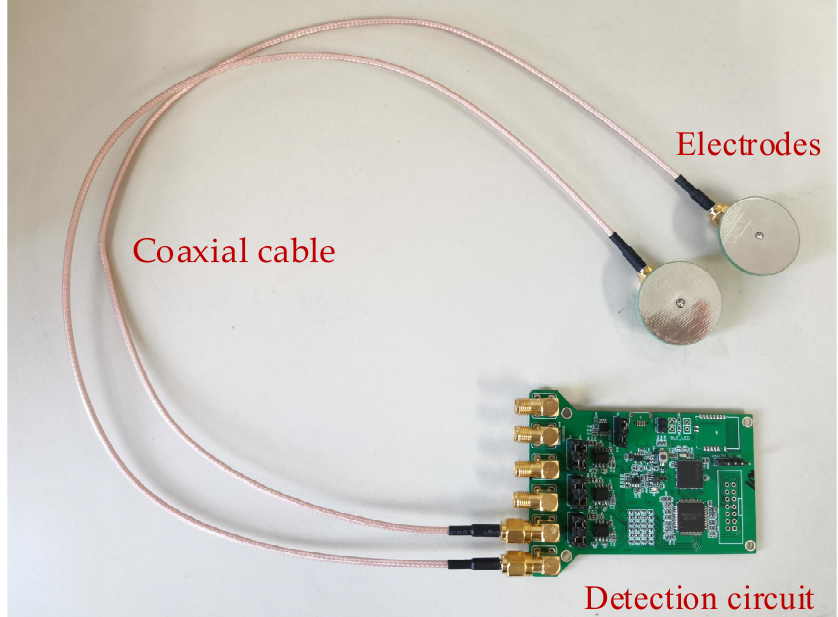
Figure 8. The detection circuit of the infrared system.